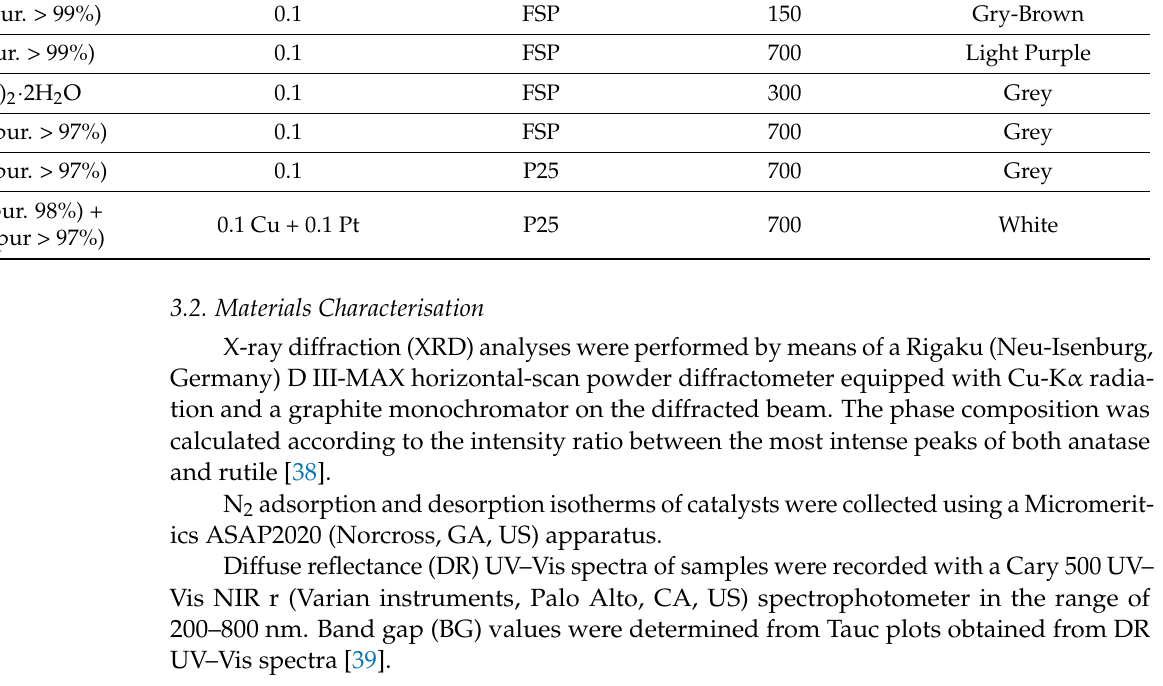
Table 2. Details for preparation of each catalyst through wet impregnation. Acac: acetylacetonate. Precursor Metal Loading (%mol) Titania Source Reduction T ( ◦ C) Colour AgNO 3 (pur. > 99%) 0.1 FSP 150 Gry-Brown AuCl 3 (pur. > 99%) 0.1 FSP 700 Light Purple Pd(NO 3 ) 2 · 2H 2 O 0.1 FSP 300 Grey Pt(acac) 2 (pur. > 97%) 0.1 FSP 700 Grey 0.1 P25 700 Grey